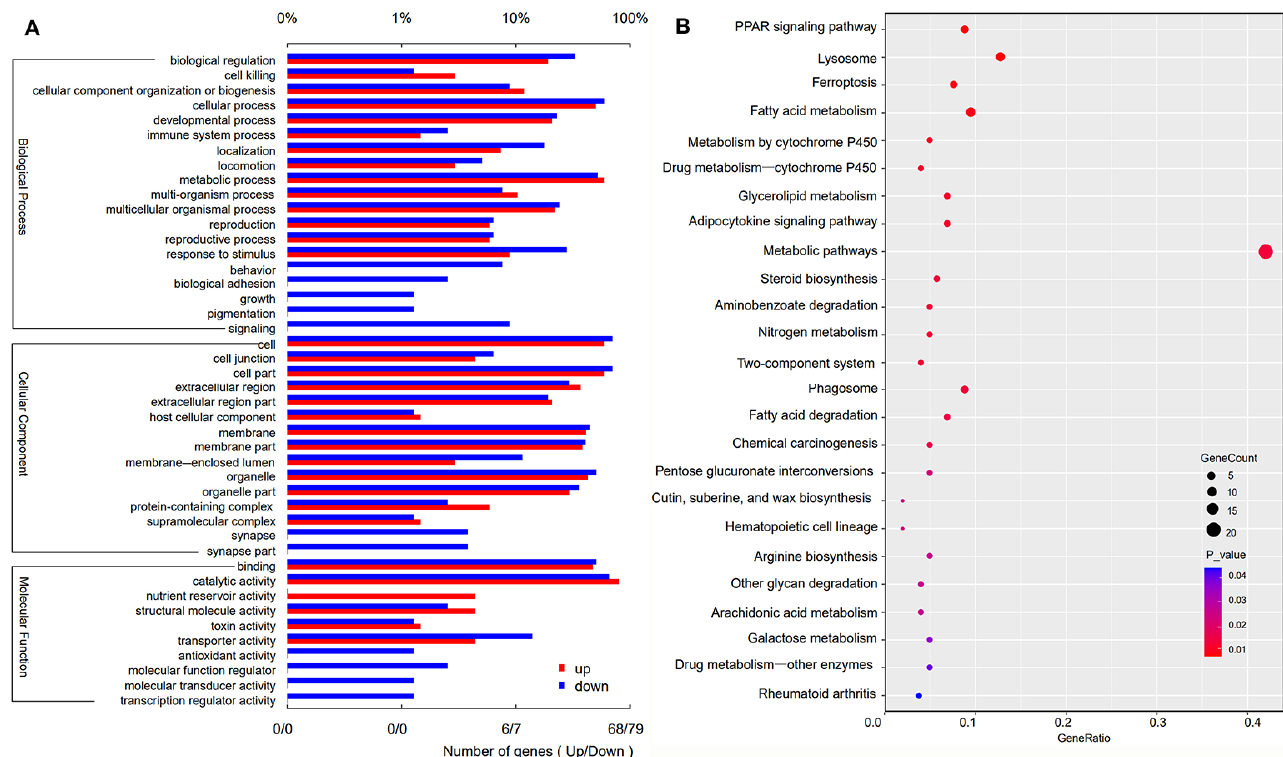
Figure 4. GO term enrichment analysis for the DEGs and the distribution of pathways annotated in the Kyoto Encyclopedia of Genes and Genomes (KEGG) data library in B. odoriphaga larvae after infection with M. hiemalis